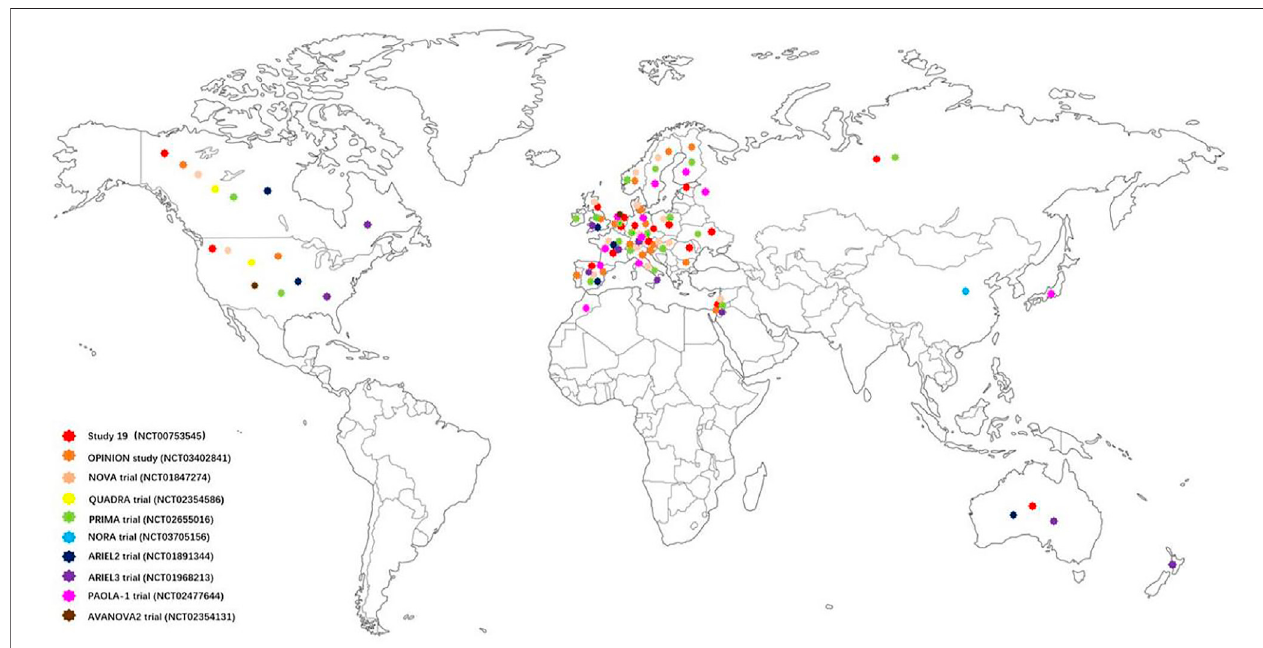
FIGURE 3 | Geographical distribution map of the subjects in some selected key studies of PARP inhibitors in ovarian cancer with non-BRCA mutations. The subjects in study 19, OPINION study, NOVA trial, QUADRA trial, PRIMA trail, NORA trail, ARIEL2 trail, ARIEL3 trail, PAOLA-1 trail and AVANOVA2 trail are marked with dots of different colors. It can be seen that most of the subjects came from the United States, Canada, and some countries in Europe.